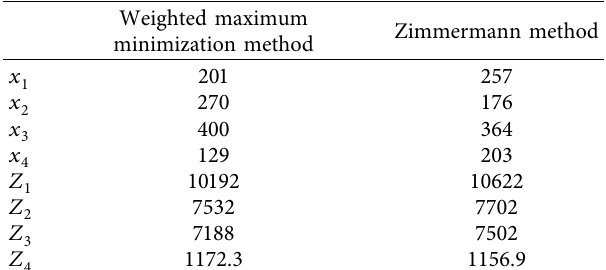
Table 9: Comparison of optimal solutions of different